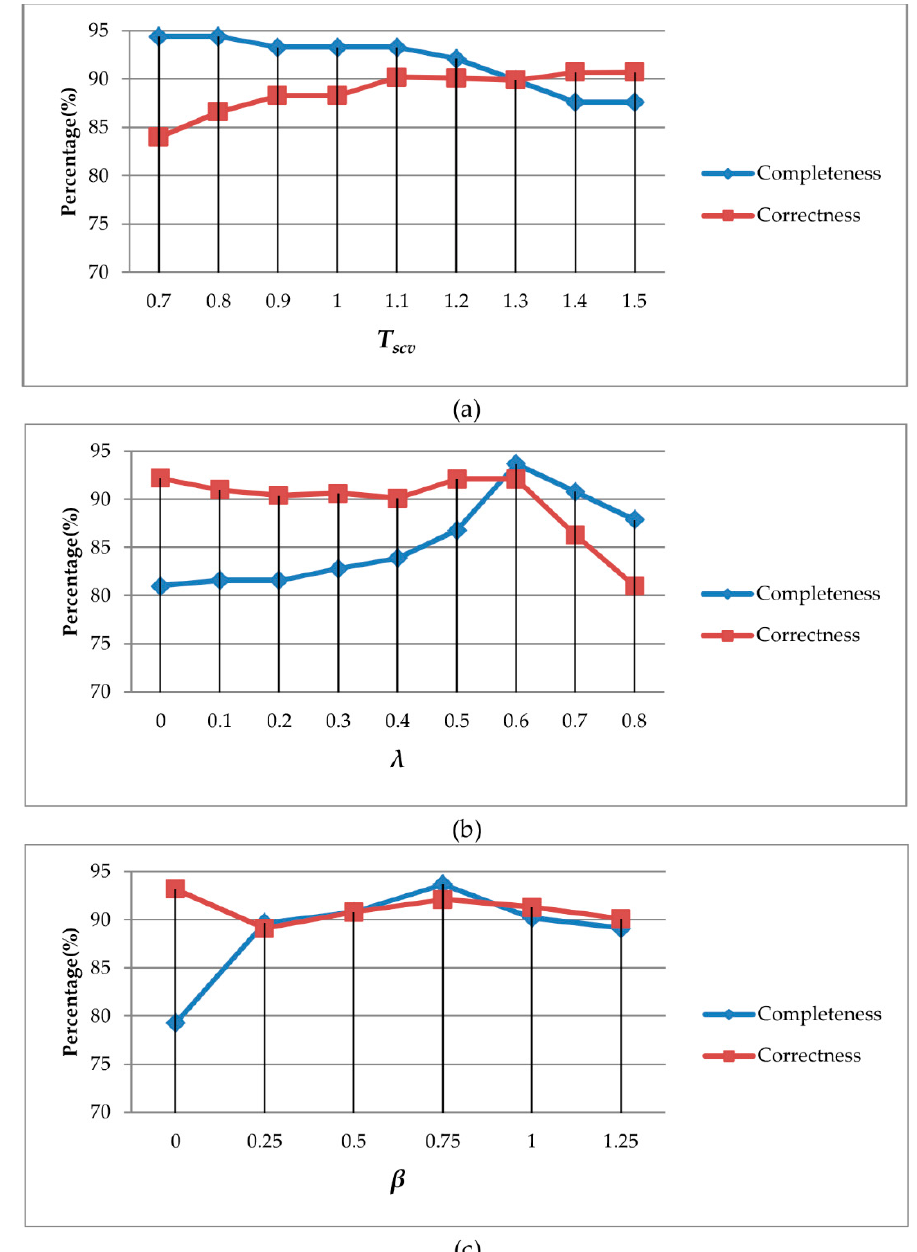
Figure 14. Sensitivity analysis of three key parameters: ( a ) threshold for squared coefficient of variation of the histogram T scv ; ( b ) Parameter λ ; and ( c ) Parameter β